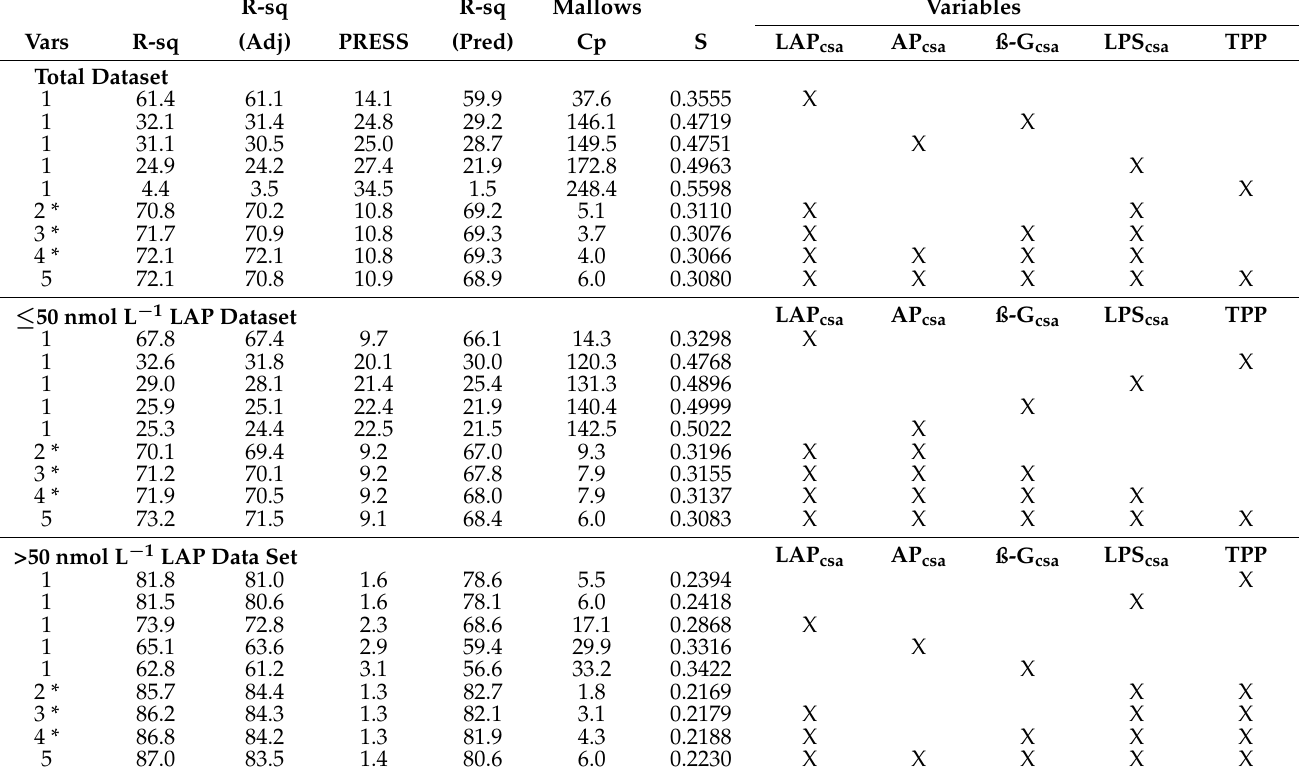
Table 3. Exploratory best subsets log-log regression analysis of specific heterotrophic